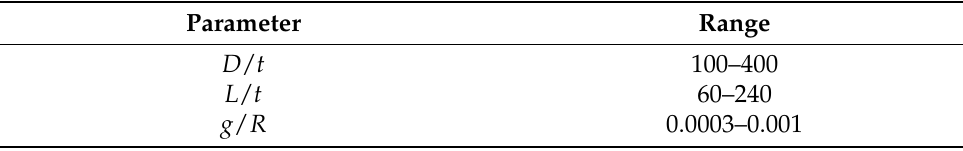
Table 2. Usual values of the geometrical parameters of a steel liner.